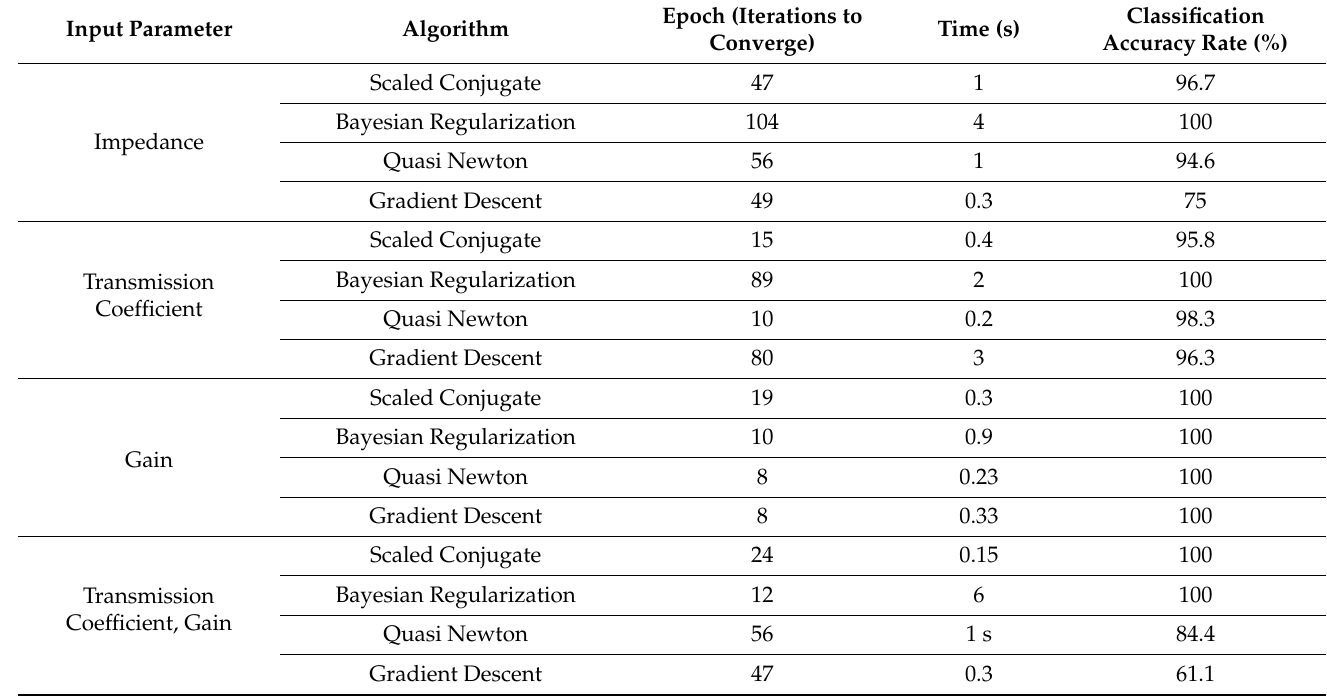
Table 4. Classification Performance between cracked and healthy